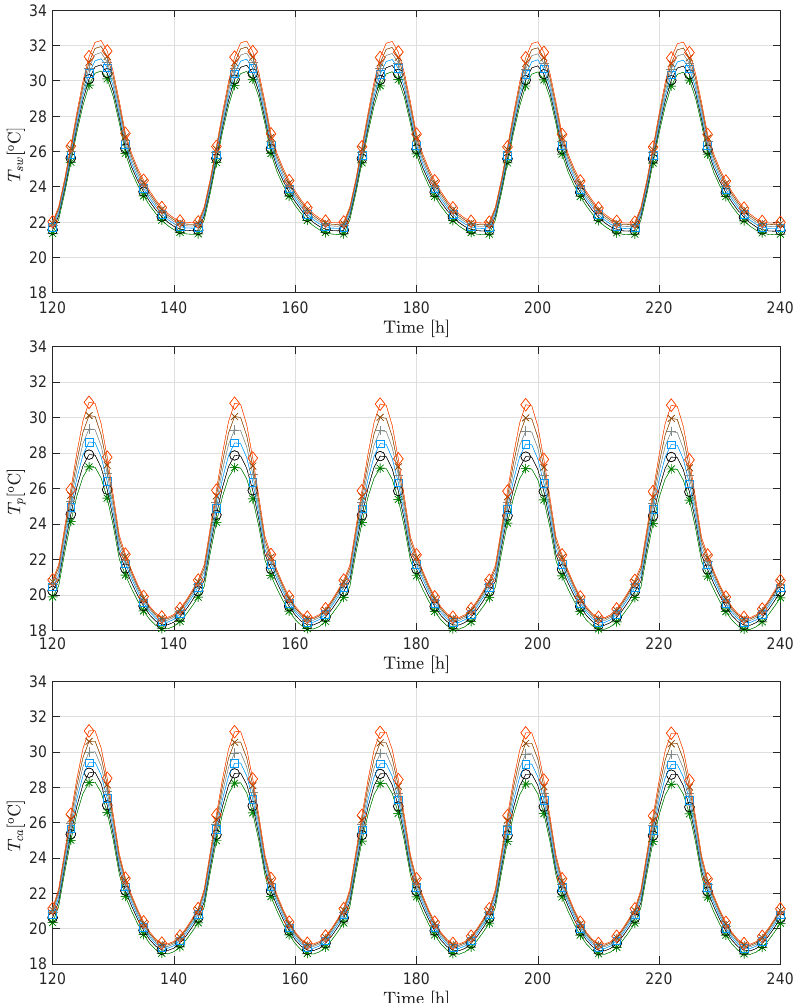
Figure 6. Facade surface temperature T sw (above), plant temperature T p (in the middle) and canopy air temperature T ca (below) distribution over time—sensitivity to minimum stomatal internal leaf resistance parameter, r i , min : ( ∗ ) 80 s/m; ( ◦ ) 120 s/m; ( (cid:3) ) 160 s/m; (+) 200 s/m; ( × ) 240 s/m; ( (cid:5) ) 280 s/m.